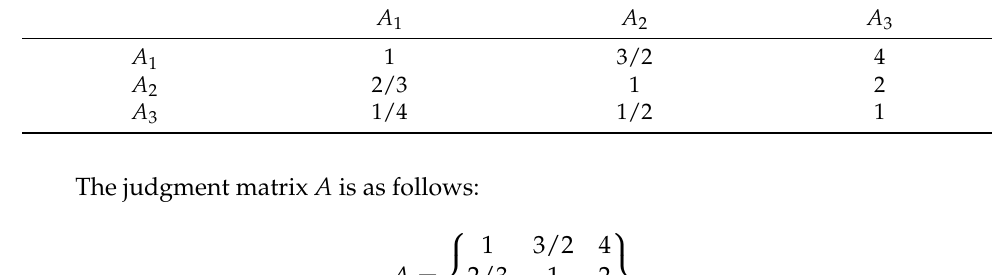
Table 4. The importance of the three basic data of dynamic obstacle avoidance. A